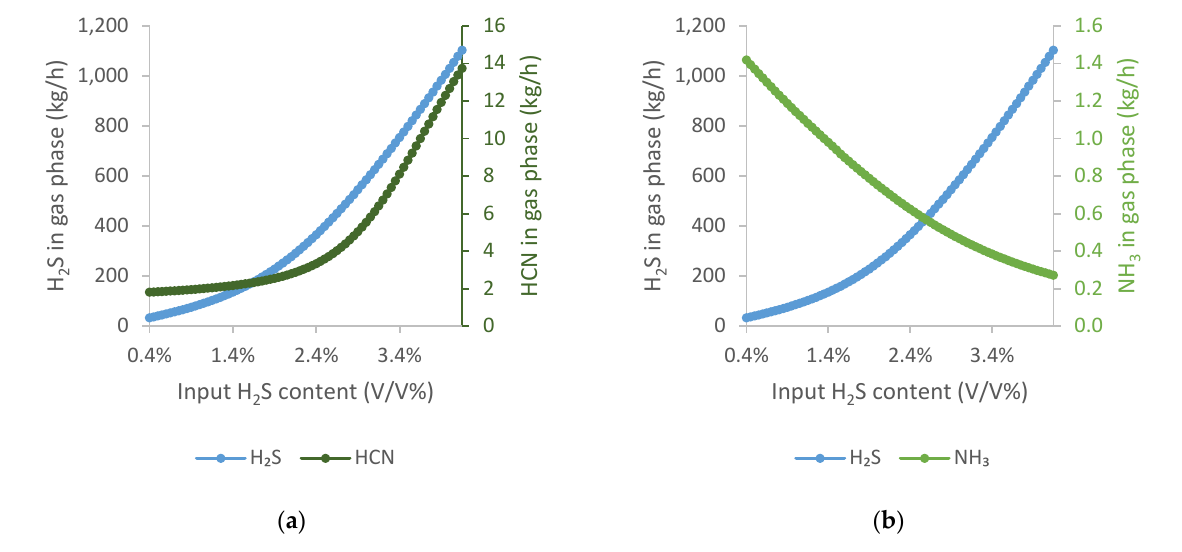
Figure 9. Effect of H 2 S content in coke oven gas ( a ) and temperature ( b ) of coal water. Table 6. Actual and optimised operation